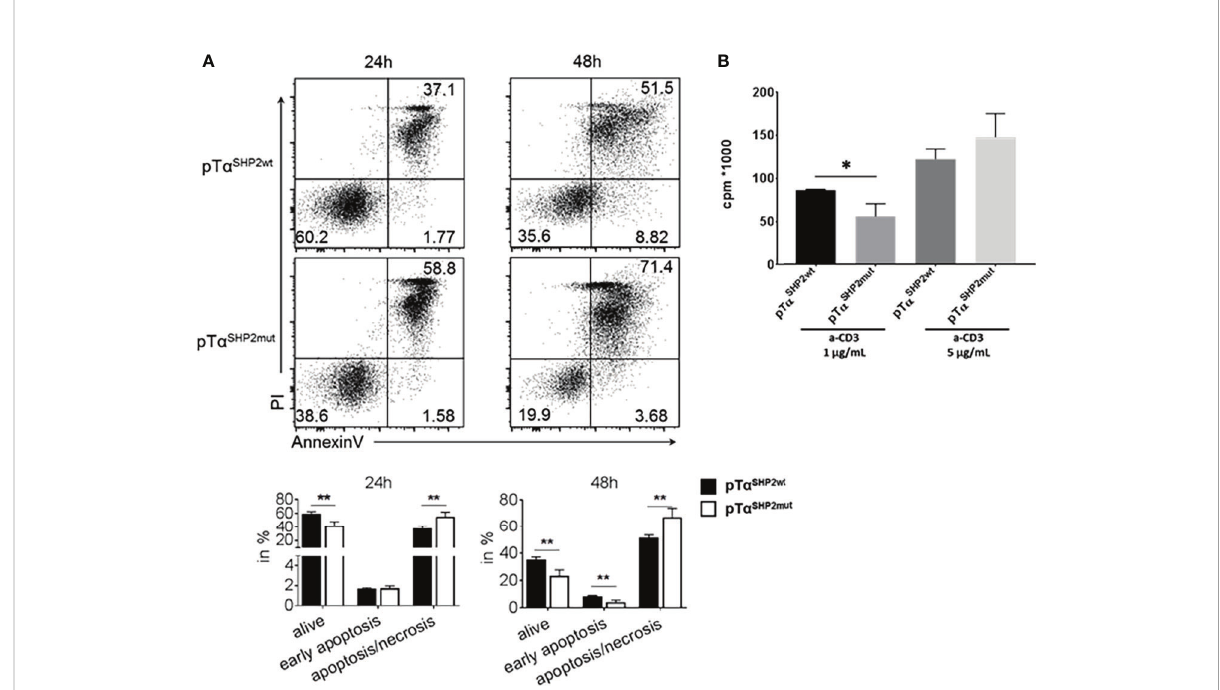
FIGURE 4 Increased late apoptosis/necrosis and reduced cell proliferation upon TCR triggering in pT a SHP2mut mice. T cells were puri fi ed from splenocytes and incubated for the indicated time points. (A) T cells were incubated for 24 or 48 h with plate-bound a -CD3 and soluble CD28 and stained with AnnexinV and PI. FACS plots and graphs show increased late apoptosis (AnnexinV, PI double positive staining) in T cells with the SHP2- D61Y mutation. Data are representative for 3 independent experiments with n=3 control and 3 pT a SHP2mut mice. (B) T cells were incubated with 1 or 5µg/mL a -CD3 for 72 h, proliferation was assessed by 3 H thymidine incorporation. Data are representative for 2 independent experiments with n=3 mice each. (*p<0.05, **p<0.01, Student ’ s t-test, mean +